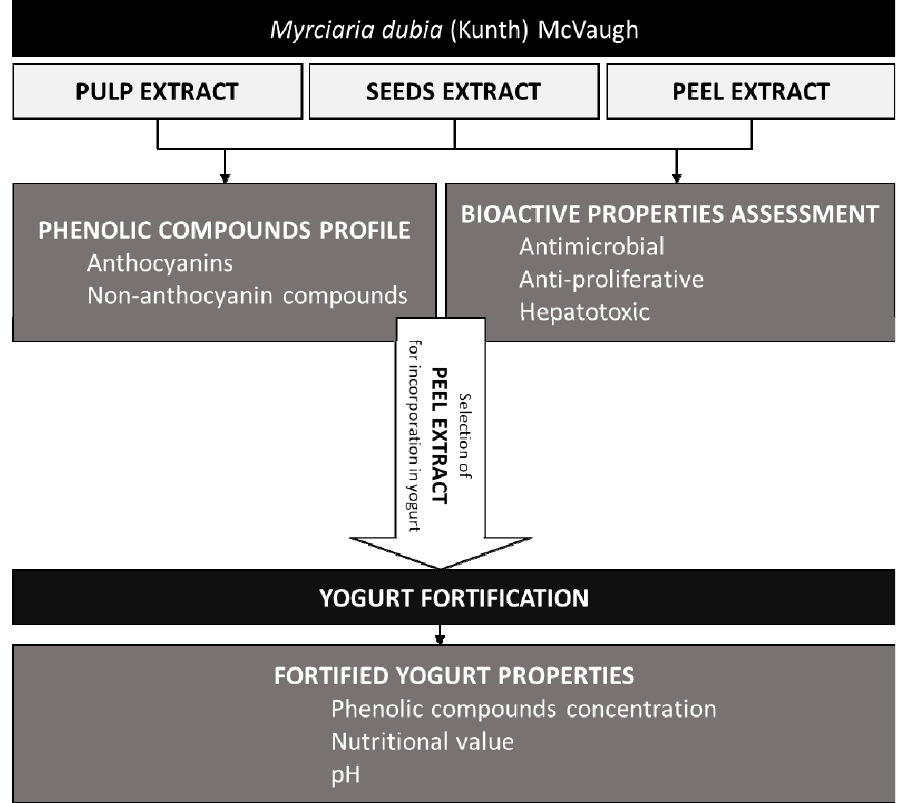
Figure 1. Overview of the experimental methodology.